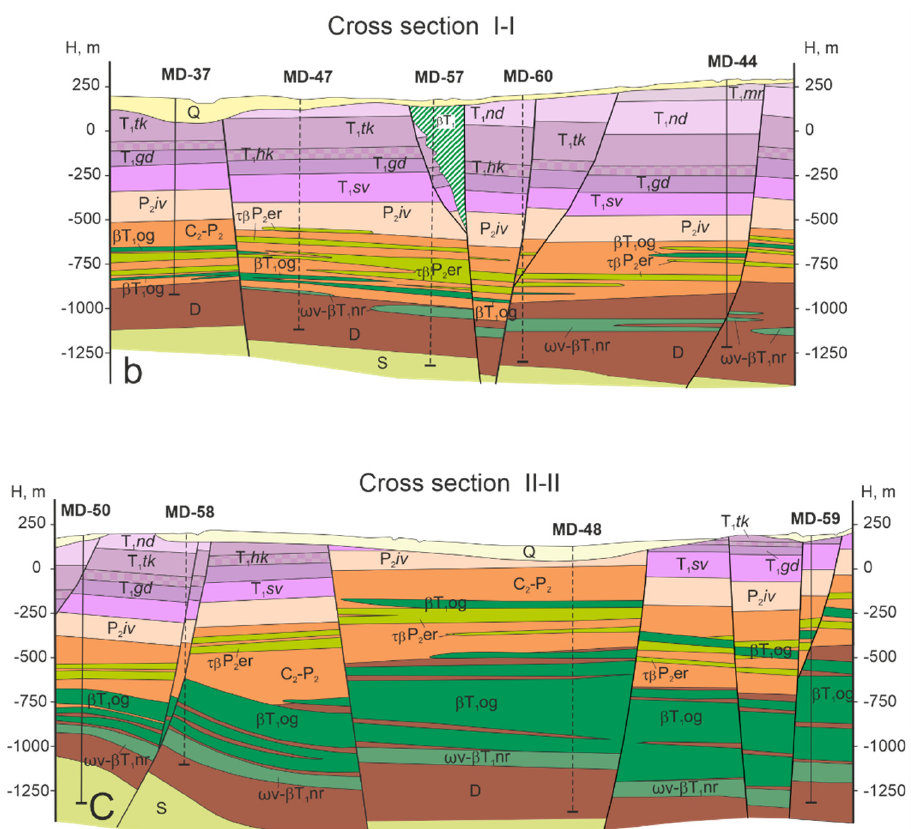
Figure 2. Geological map of the Mikchangda area ( a ) and sections along the lines I-I ( b ) and II-II ( c ). Compiled by the authors based on the Norilskgeologiya LLC data (author V.N. Mikhailov), with